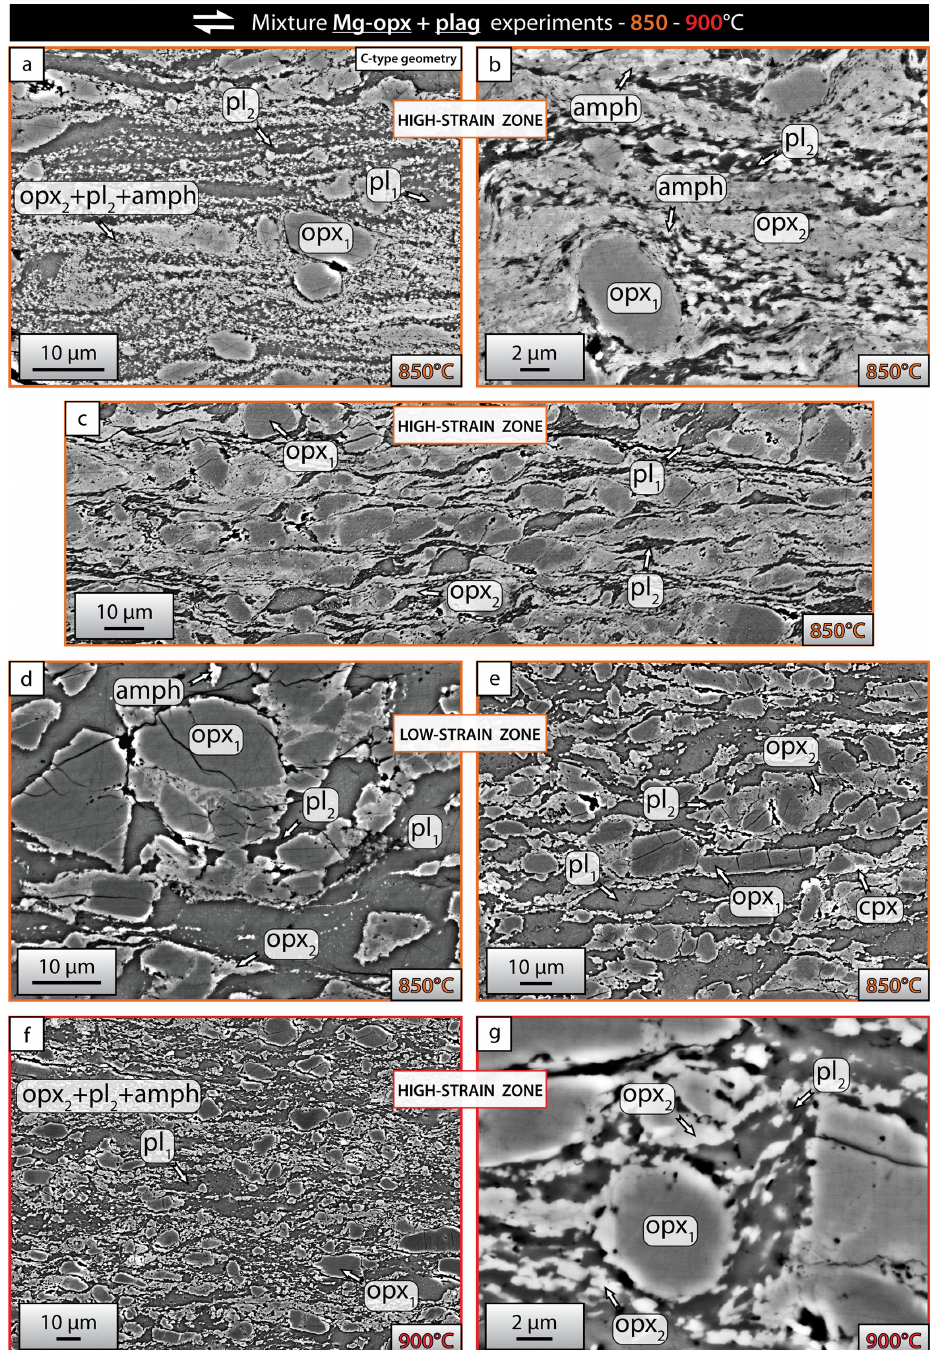
Figure 4. SEM BSE images representative of microstructures observed in deformed Mg-rich opx + plag assemblages; opx 2 and plag 2 are the main reaction products. (a–b) At 850 ◦ C, mineral reactions are mainly localized in the high-strain zones in the form of fine-grained mixed zones. (c) The original plag 1 almost completely disappears. (d) In low-strain zones, the reaction products appear as coronas around the original opx1 and as aggregates; (e) opx 1 is locally fractured and filled with reaction products. (f–g) Similar microstructures are observed at 900 ◦ C, although deformation is less localized compared to the assemblage deformed at 850 ◦ C. opx: orthopyroxene, pl: plagioclase, amph: